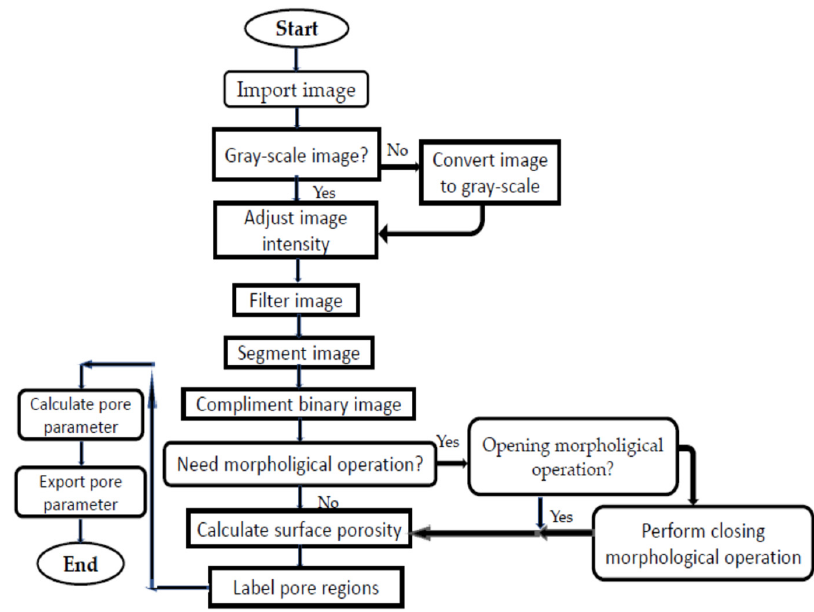
Figure 2. Algorithm of image processing and analyses executed in MATLAB R2017a Reproduced from [18], with permission from Polymers, 2019.